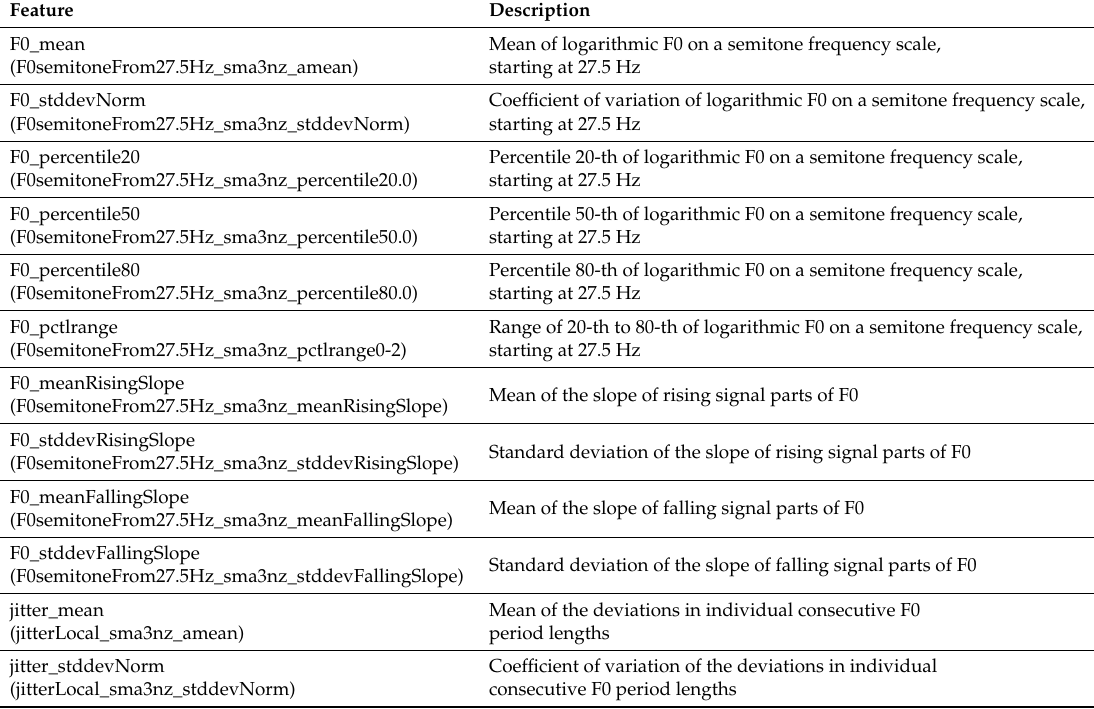
Table A1. Frequency features explained. All functionals are applied to voiced regions only. Text in brackets shows the original name of the eGeMAPS features.